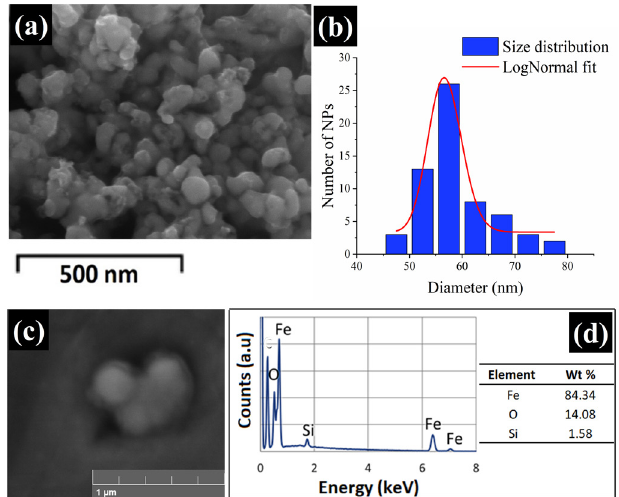
Figure 5. Representative SEM images of Fe@SiO nanoparticles. (d) EDS spectrum and representative elemental quantitative data of Fe@SiO